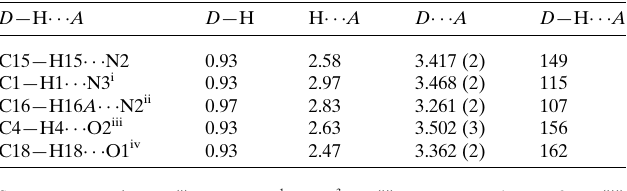
Table 1 Hydrogen-bond geometry (A˚ , (cid:4)